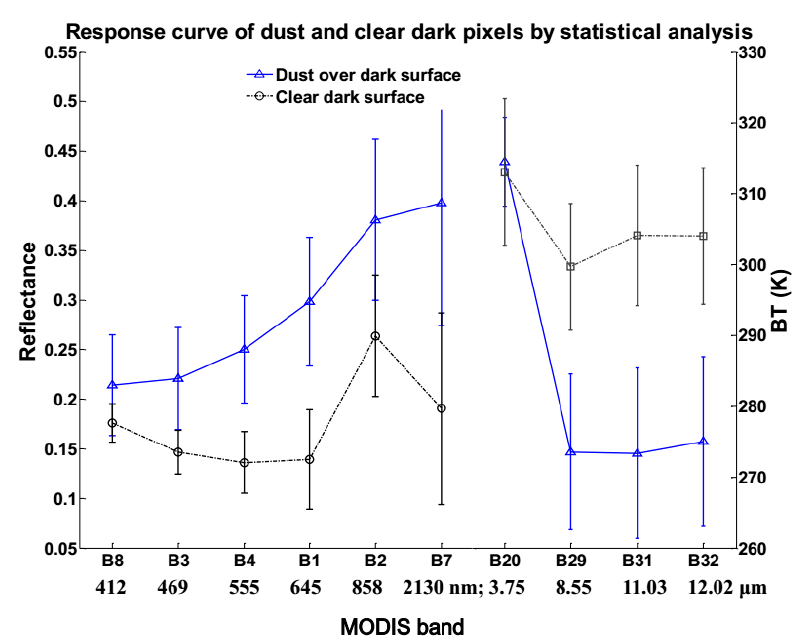
Figure 2. Response curves of dust and clear dark pixels.